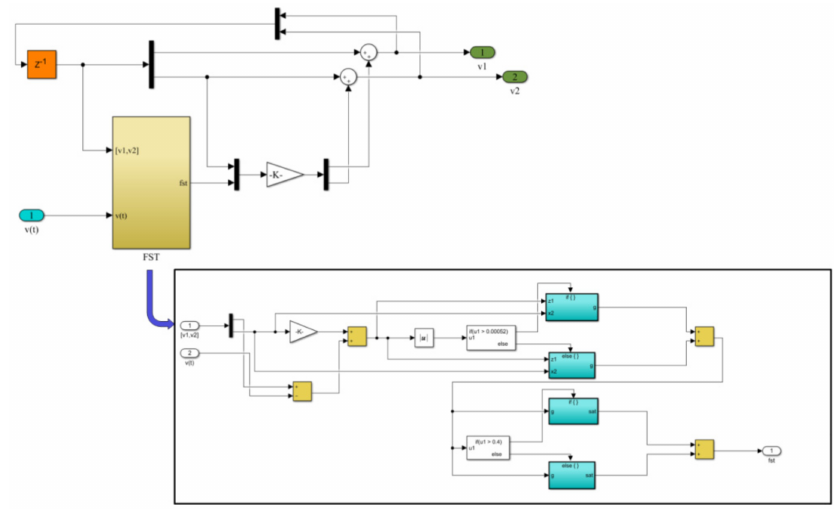
Figure 7. Simulation model of nonlinear tracking differentiator.